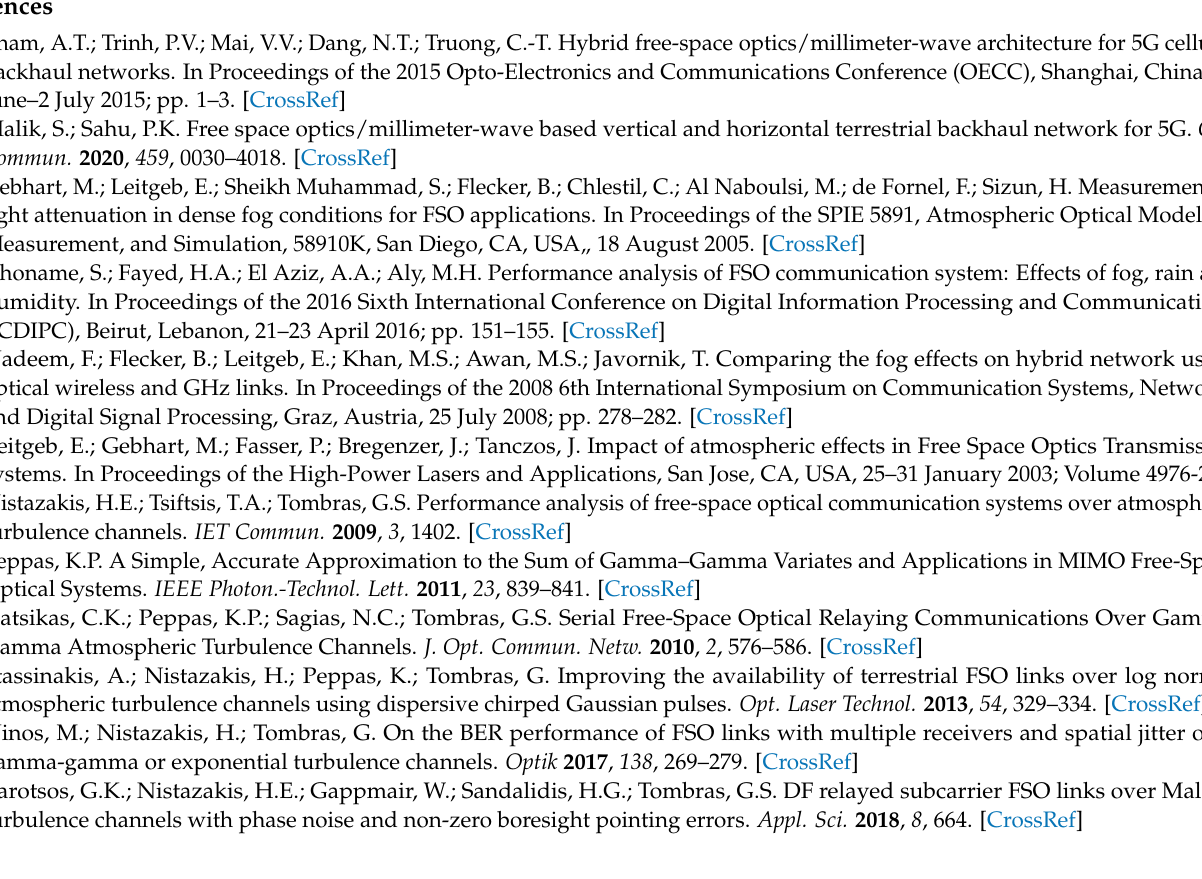
Figure A2. RSSI and Optical power linear fitting.